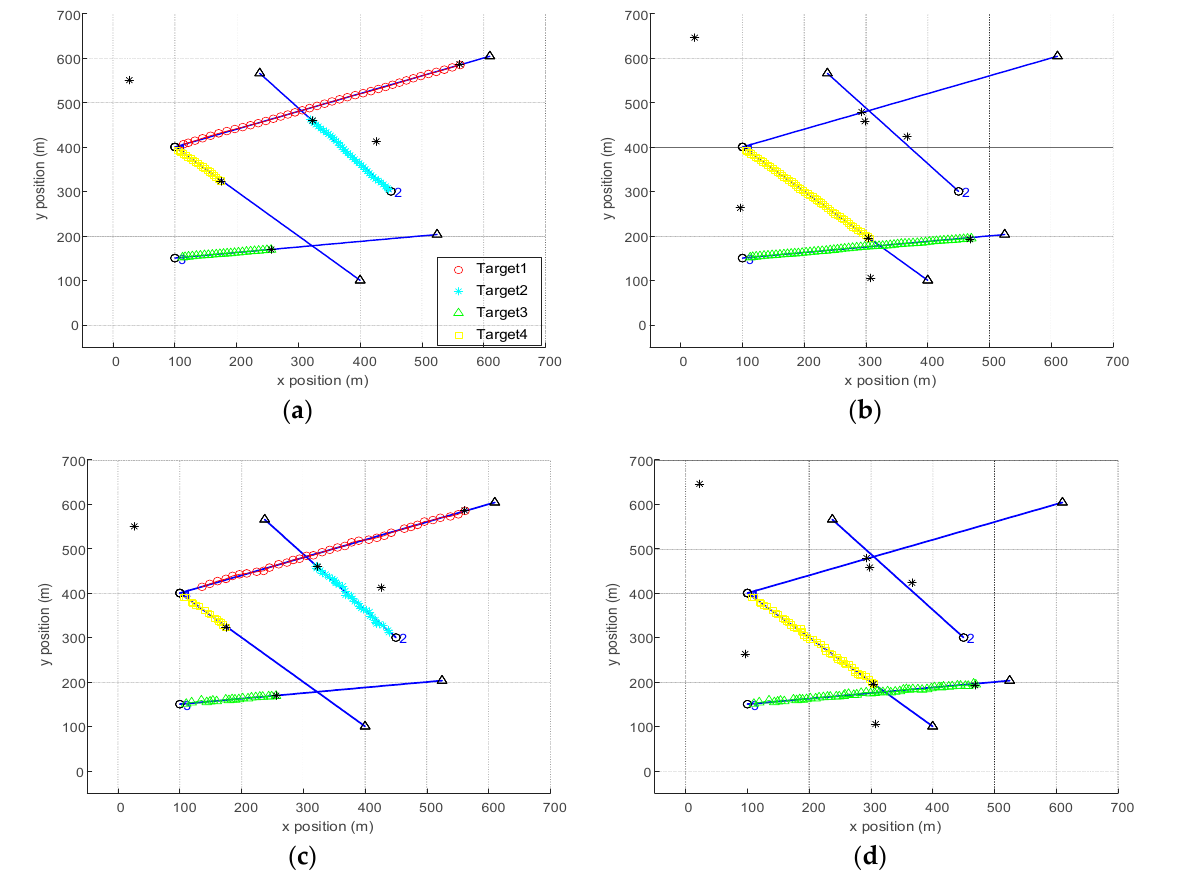
Figure 1. ( a ) The trajectory estimates of AGM-VB-TPHD until time 40. ( b ) The trajectory estimates of AGM-VB-TPHD until time 75. ( c ) The trajectory estimates of AGM-tag-VB-PHD until time 40. ( d ) The trajectory estimates of AGM-tag-VB-PHD until time 75. The blue line represents the true trajectories of the targets in the period, the circle represents the starting point of the trajectory, the triangle represents the end point of the trajectory, different trajectories are marked with different color styles and the black asterisk represents the measurement at the current time.